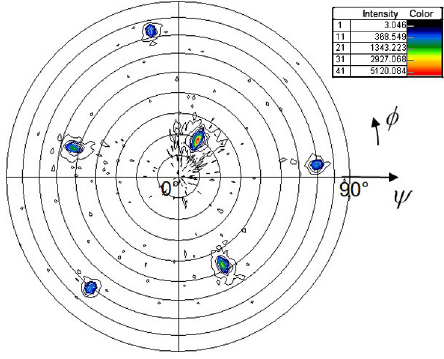
FIG. 24. Niobium (1 1 0) pole figure measured on sample L51. O (red). 3 5